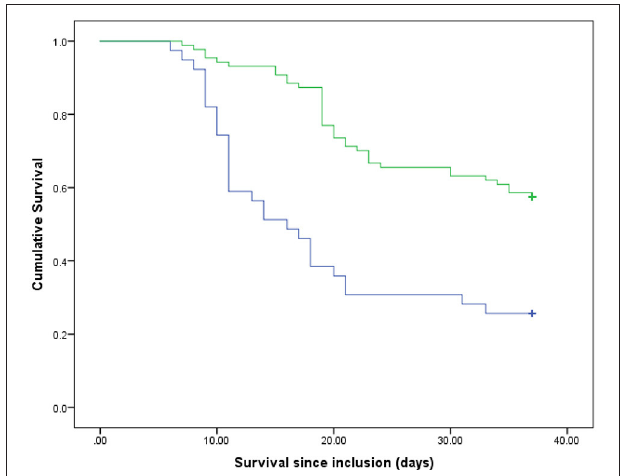
FIGURE 2 | Survival rates of the participants compared between two groups of the energy intake ratio. Blue line, patients with lower than median of the energy intake ratio; green line, patients with higher than median of the energy intake ratio. P = 0.015 (log rank).